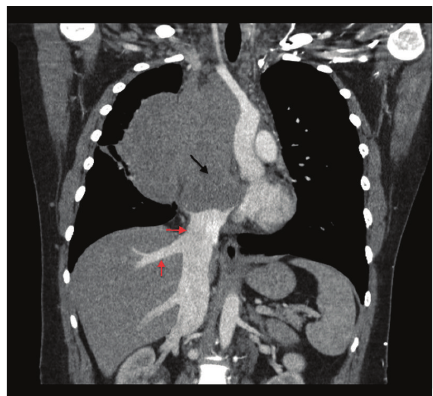
Figure 2: Coronal CT scan image elucidates a mediastinal mass with extension into the right atrium (black arrow) with complete encasement and compression of the SVC. The tumor extends to the confluence of the IVC in the right atrium causing dilatation of the intraabdominal IVC and hepatic veins suggesting compromised cardiac return (red arrows). Tumor causes the displacement of great vessels into the left hemithorax.